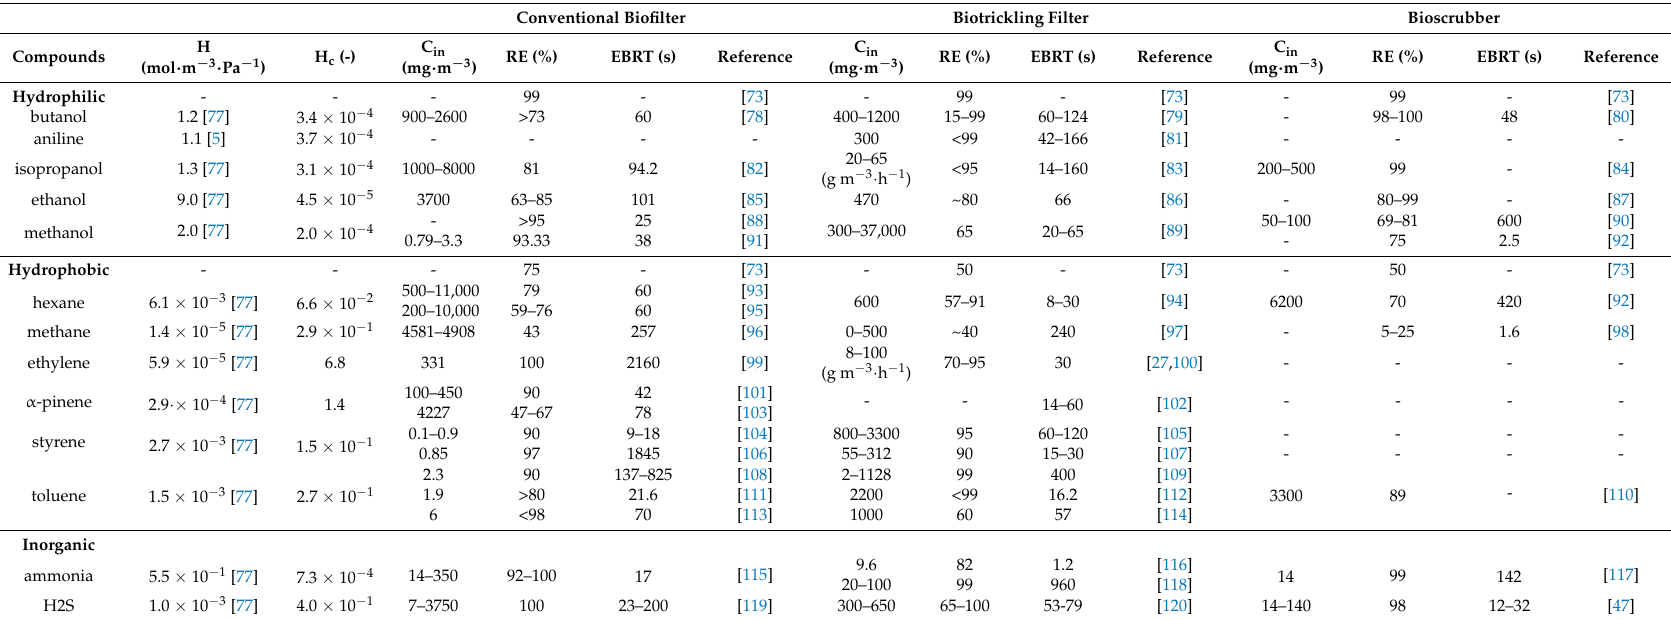
Table 2. Literature data for determining the values of sub-criteria 1.1 and